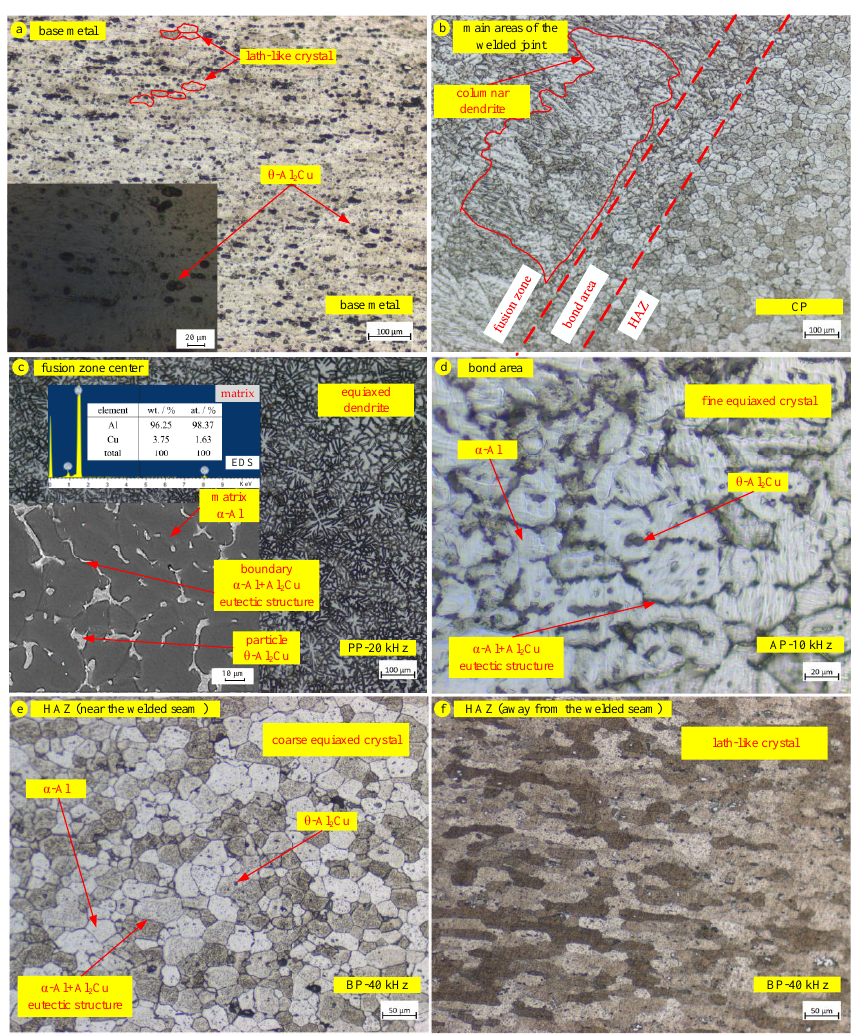
Figure 5. Microstructure of base metal ( a ), areas near the fusion line ( b ), fusion zone centre ( c ), bond area ( d ), and HAZ ( e , f ).